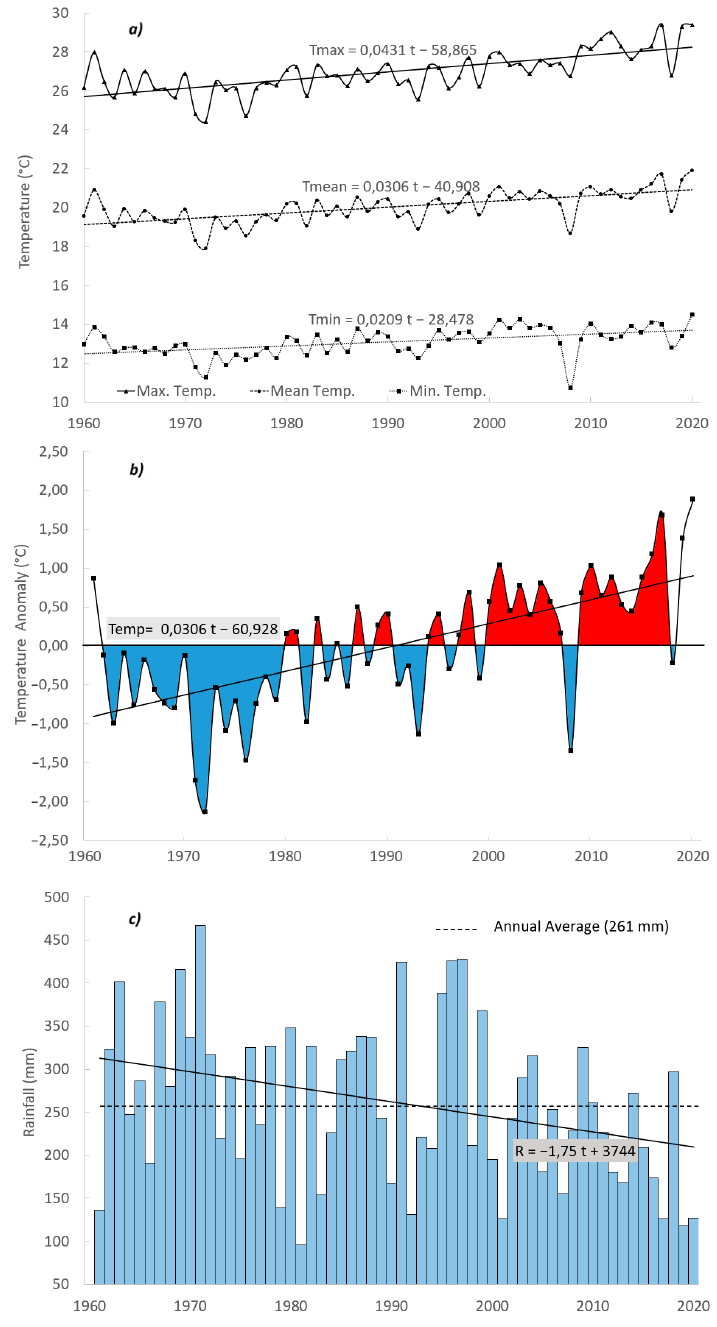
Figure 3. Annual average and extreme (averaged maximum and minimum temperatures) temperature values ( a ), temperature anomalies ( b ) and annual rainfall ( c ) for the period 1960–2020 in Marakech-Marrakesh (31 ◦ 37 (cid:48) 12 (cid:48)(cid:48) N; 8 ◦ 1 (cid:48) 48 (cid:48)(cid:48) W). The intensive use of the groundwater is exacerbated by the scarcity of stormwater and the high temperatures causing an intense evaporation and consequently a poor